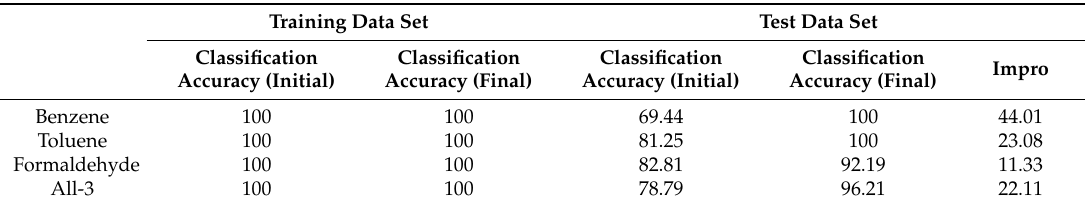
Table 9. Classification accuracy of M-training with 25%-unlabeled rate (%).